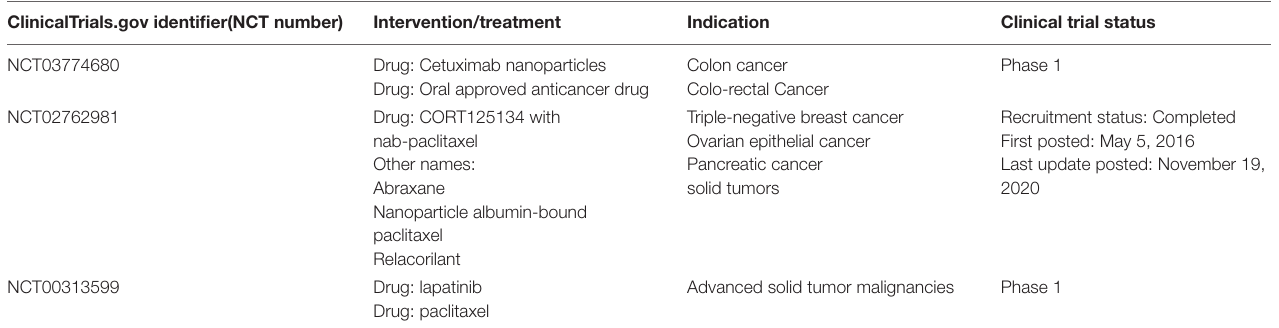
TABLE 2 | Nanoparticles that are not clinically approved but are in clinical trials (including not yet recruiting, recruiting, or active) for treatment of CRC by oral administration. ClinicalTrials.gov identifier(NCT